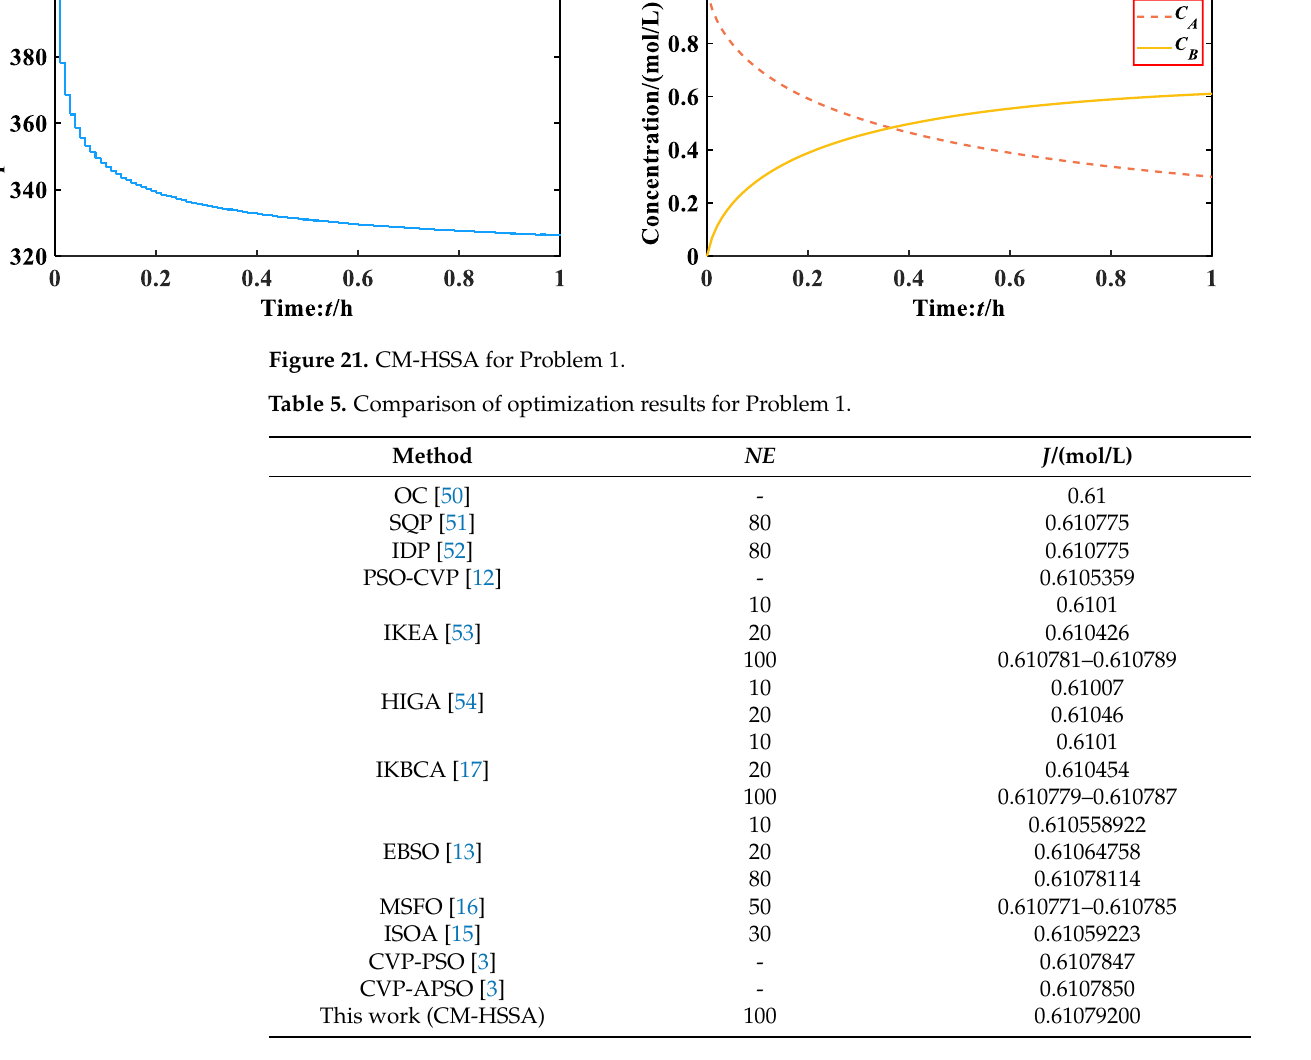
22 of 29 Table 4. Comparison of optimization results for Problem 1. Method